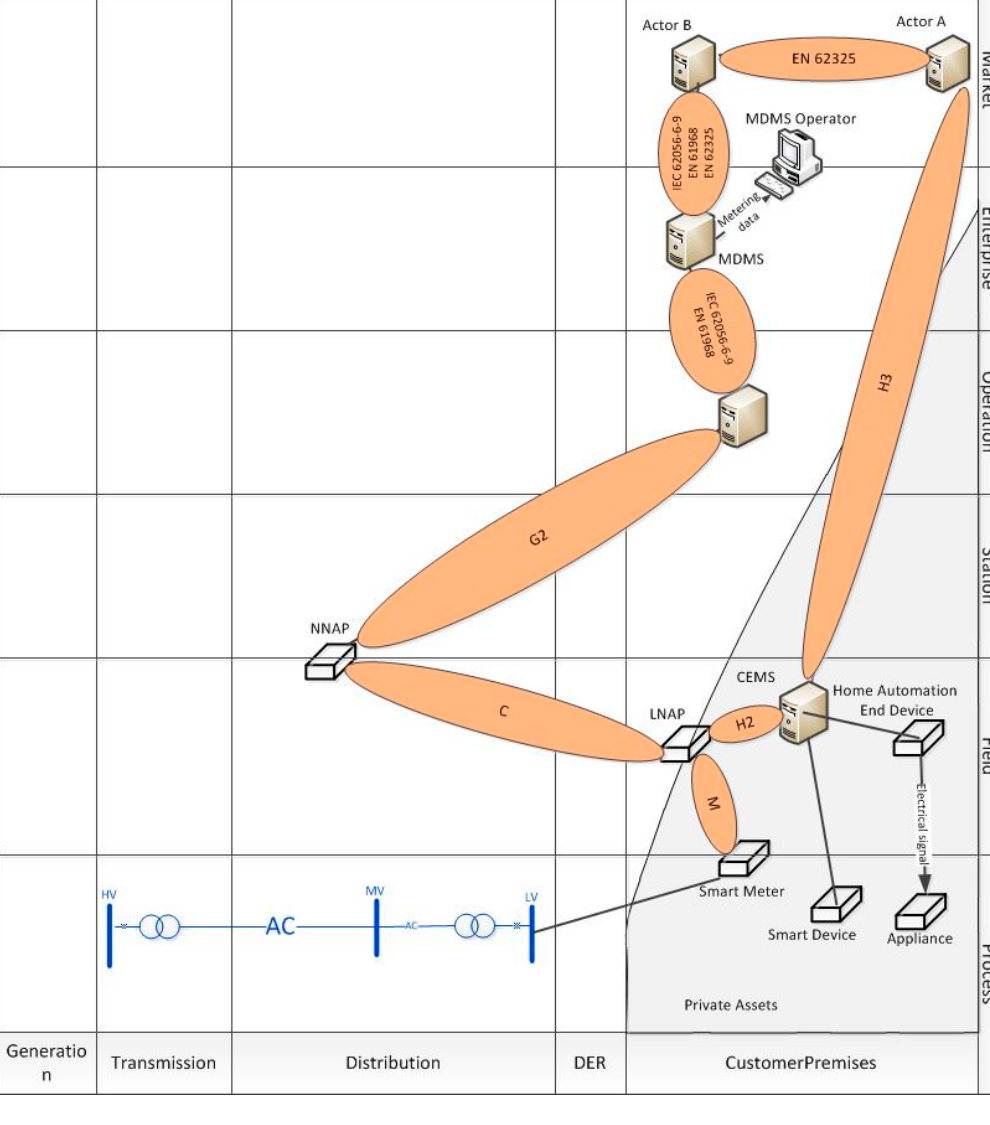
Figure 7. Information Layer. Table 3. Interfaces and standards for the information